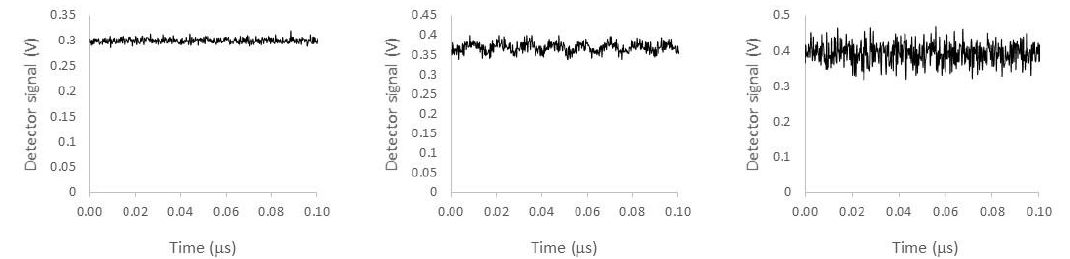
Figure 5. Time traces of the laser’s output as measured by the detector in the setup of Figure 2 at a laser injection current of 60 mA and an SOA current in the FOF path of 11 mA for different strengths of the COF by changing the current injected in SOA2 in the COF path: I SOA2 = 500 mA (left), I SOA2 = 600 mA (middle) and I SOA2 = 700 mA (right).